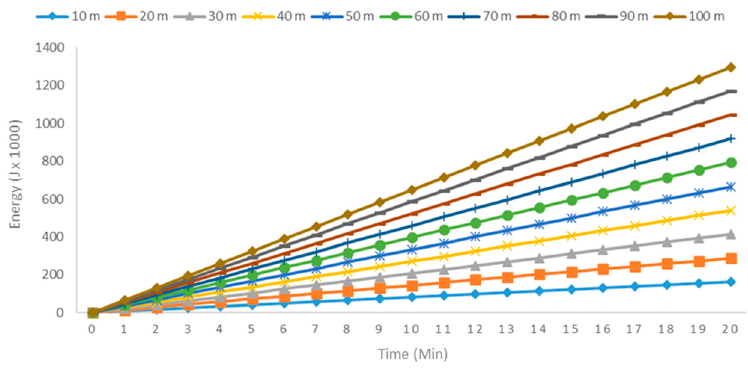
Figure 14. Energy consumption of a quadcopter drone at 10 m/s for different fh .